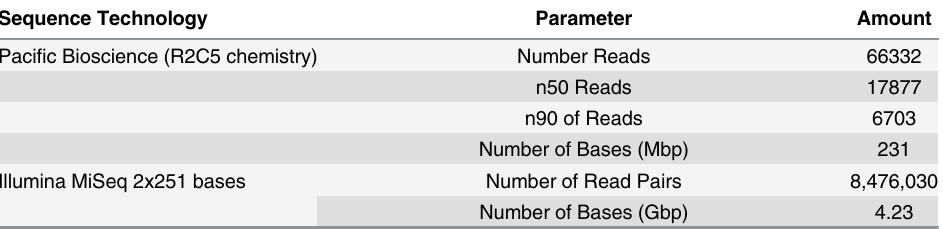
Table 3. Next generation sequence data utilized for assembly of the S . agnetis 908